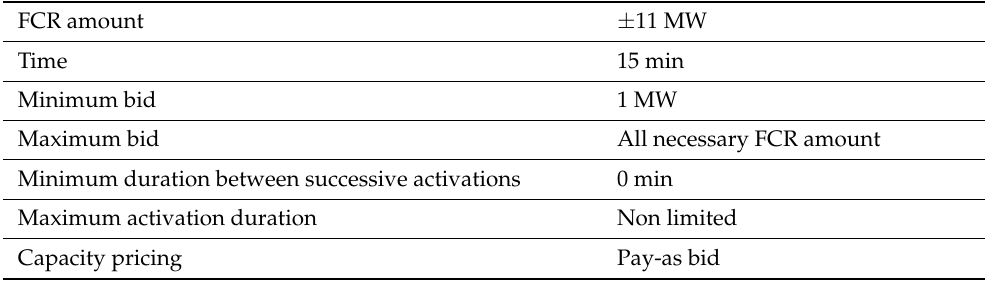
Table 3. FCR product characteristics